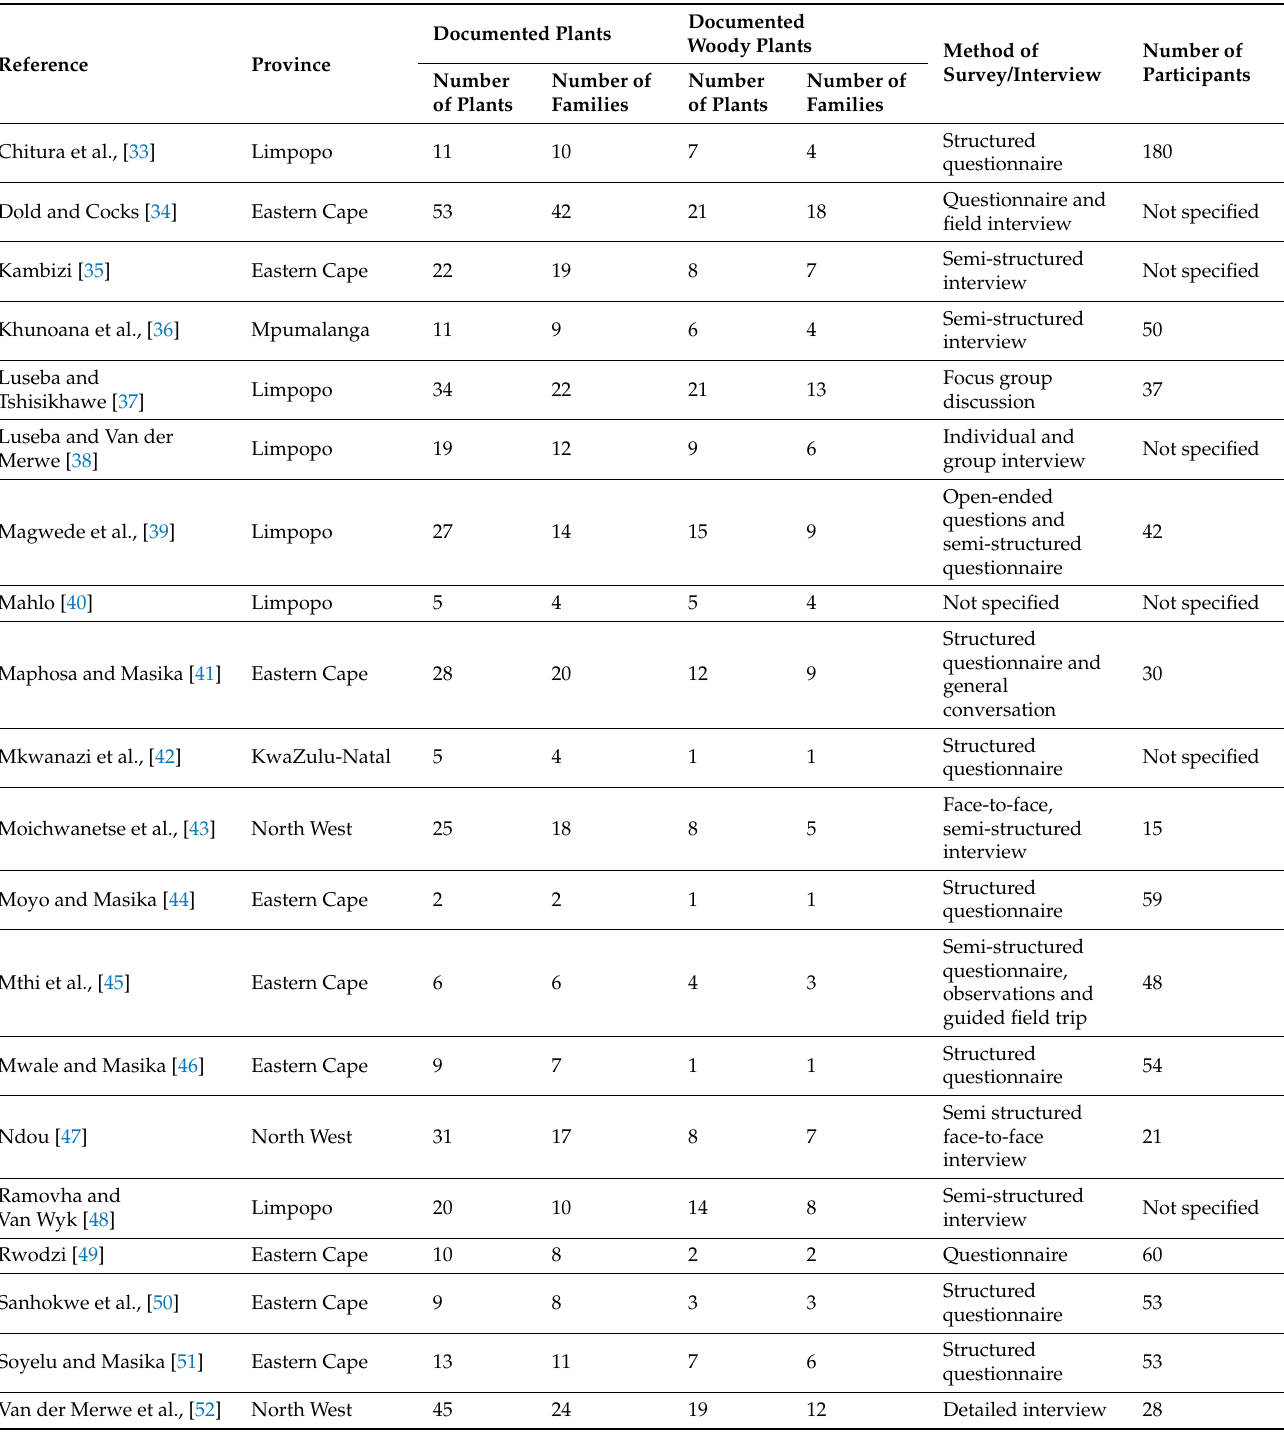
Table 1. An overview of ethnoveterinary surveys with evidence on the use of woody plants in South Africa from 2000–2020.